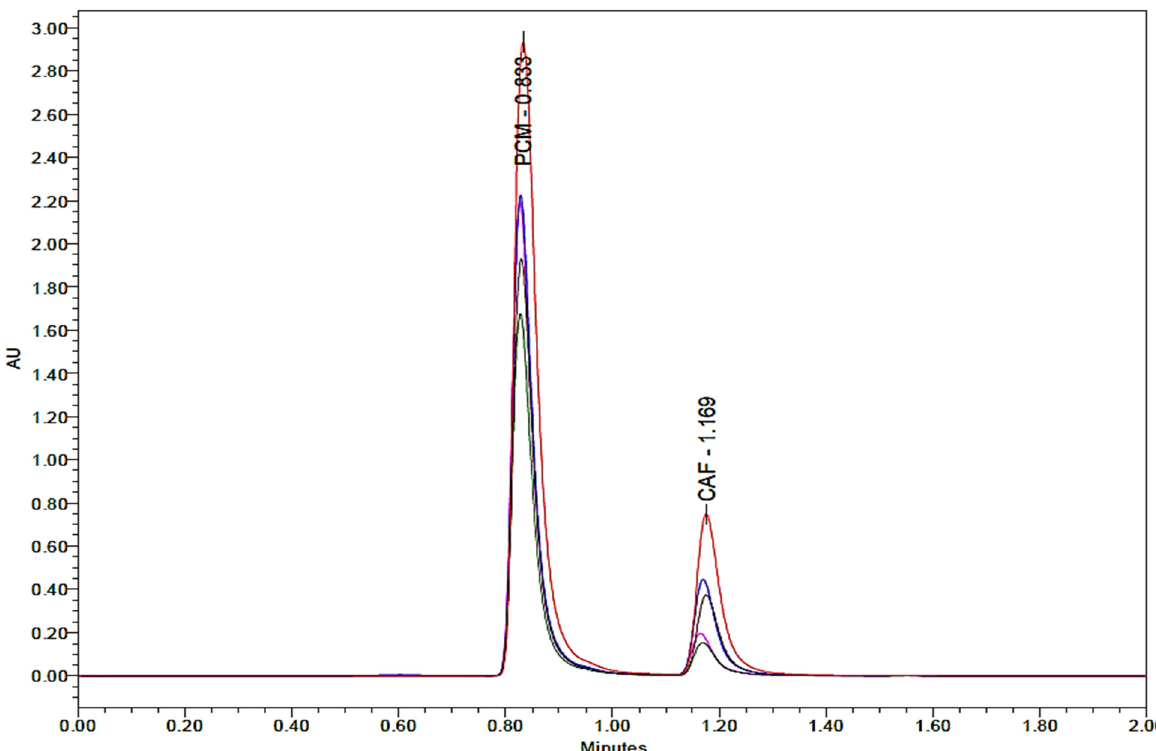
Figure 3. Chromatogram of PCM and CAF at 273 nm.